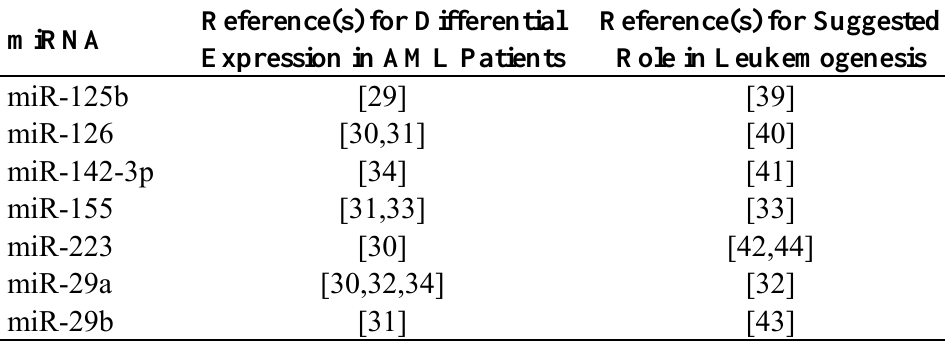
Table 1. AML-associated miRNA